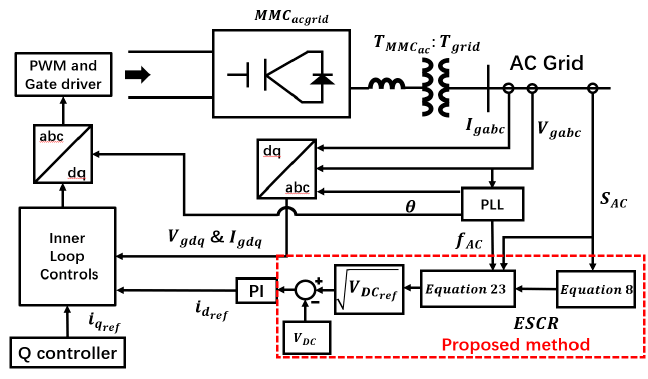
Figure 3. Improved inertia control diagram.